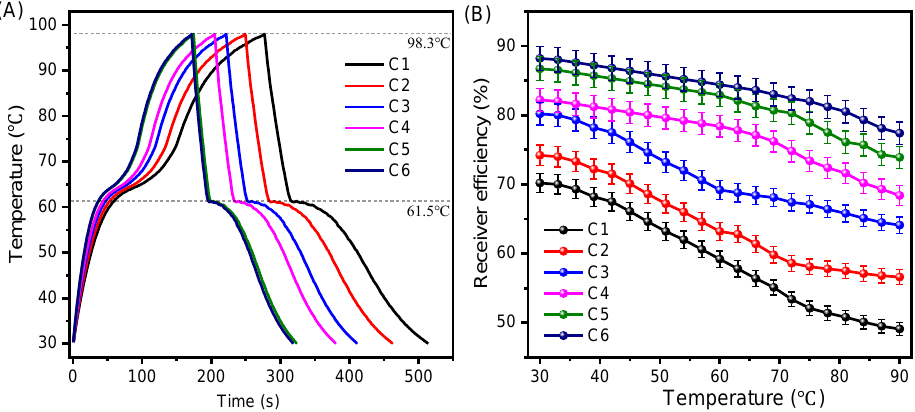
Figure 9. Melting − freezing properties of CNT-PE-EPDM/EG-based PCM sample C5 before and after Figure 9. Melting−freezing properties of CNT -PE-EPDM/EG-based PCM sample C5 before and after 200 cycles. 200 cycles.